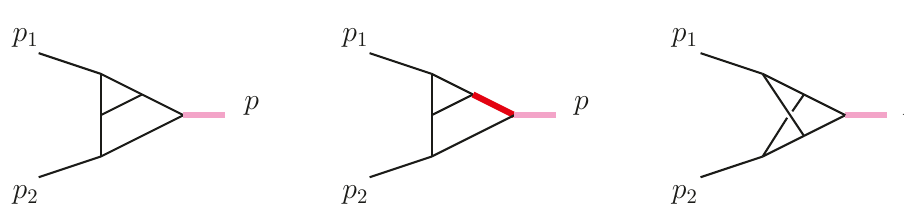
Figure 3. Three representative topologies of Feynman diagrams belonging to F 1 , F 2 and F 3 respectively for mixed QCD-QED two-loop virtual corrections to q ¯ q 0 → W ∗